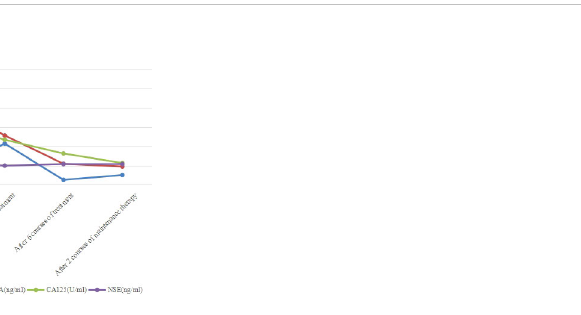
FIGURE 7 Changes in tumor marker content. Cytokeratin 19 fragment, CEA, CA125 and NSE were abnormally increased before treatment, after 2 courses of treatment, cytokeratin 19 fragment and NSE decreased signi fi cantly. After 6 courses of treatment, CEA and CA125 also decreased signi fi